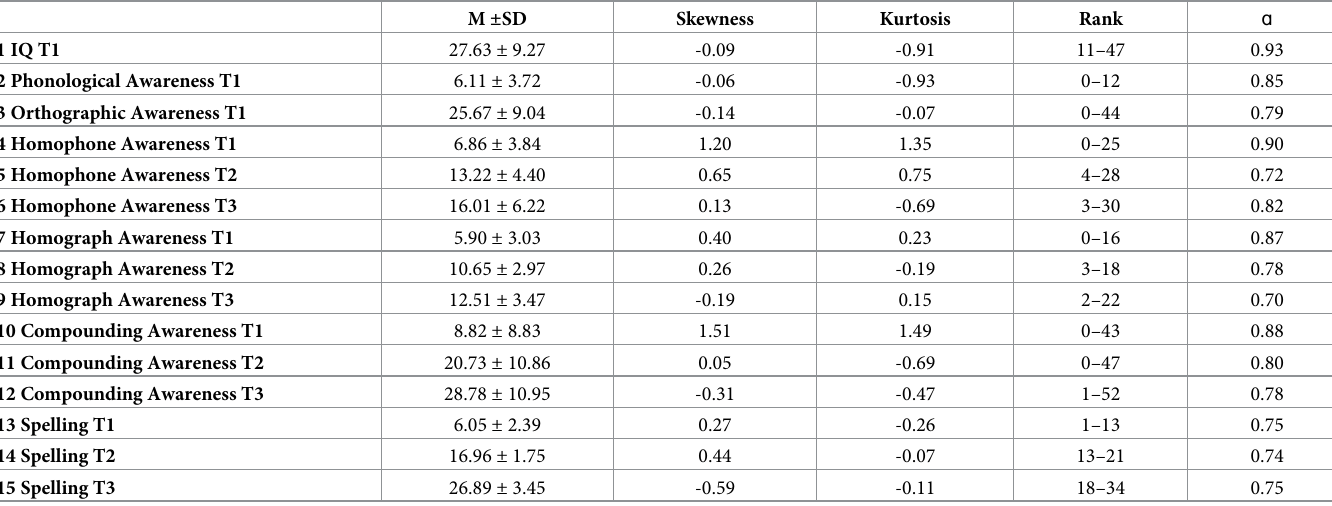
Table 1. Descriptive statistics for all variables at three time points.